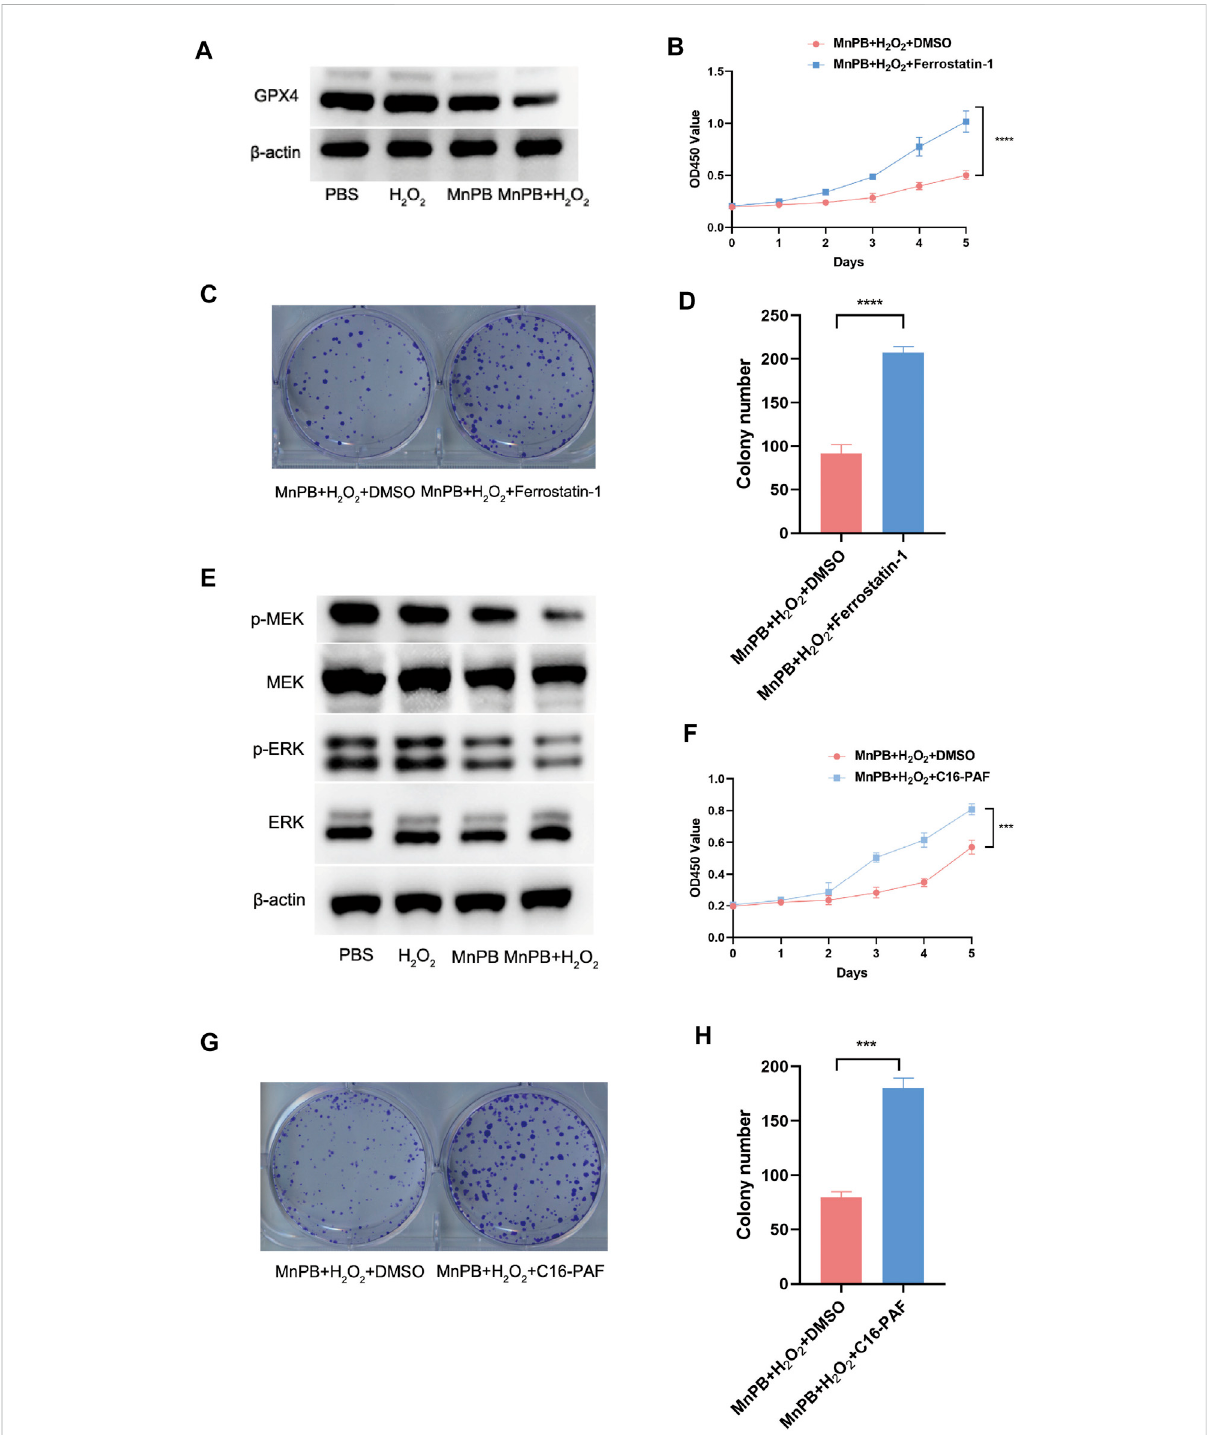
The MnPB NPs promoteferroptosis inPANC-1cells throughthe MAPK signal pathway. (A) The expressionlevel of GPX4 indifferenttreatments. (B) Cell viability was analyzed by CCK-8 assay at the indicated time in PANC-1 cells with DMSO or Ferrostain-1. (C) The colony formation assay of PANC-1 cells with DMSO or Ferrostain-1. (D) The statistical analysis of colony formation assay of PANC-1 cells with DMSO or Ferrostain-1. (E) Western blotting showed the effects of different treatments on the MAPK pathway in PANC-1 cells. (F) Cell viability was measured by CCK-8 assay at the indicated time in PANC-1 cells with DMSO or C16-PAF. (G) The colony formation assay of PANC-1 cells with DMSO or C16-PAF. (H) The statistical analysis of colony formation assay of PANC-1 cells with DMSO or C16-PAF. * p < 0.05; ** p < 0.01; *** p < 0.001; **** p <